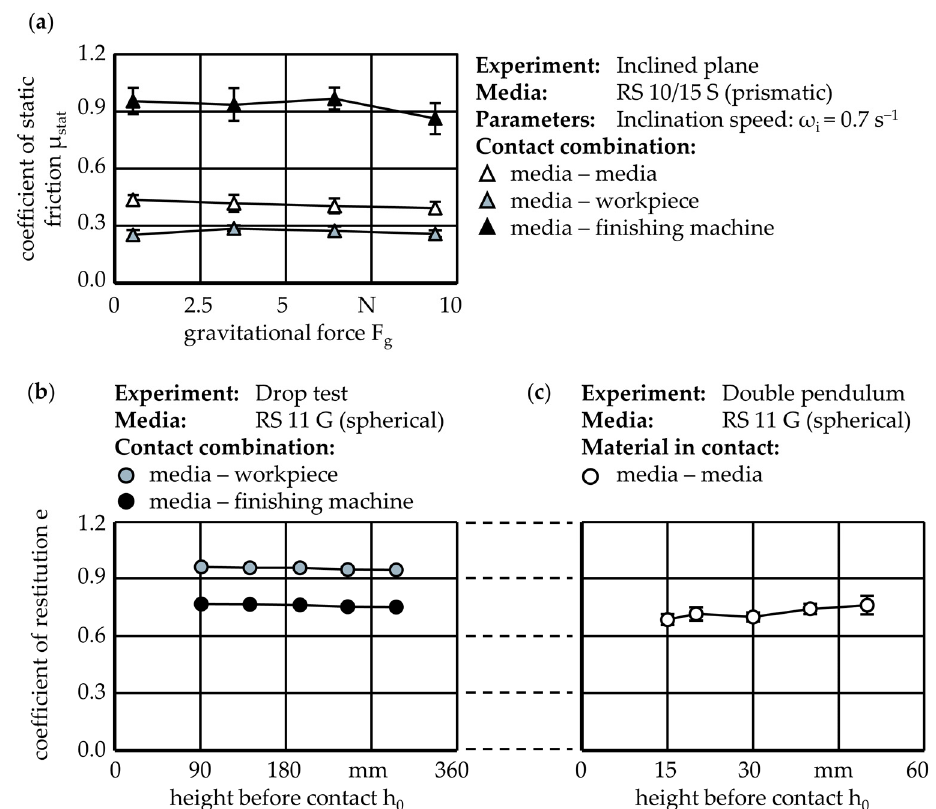
Figure 7. Results of DEM parameter determination: ( a ) inclined plane; ( b ) drop test; ( c ) double pen- dulum.